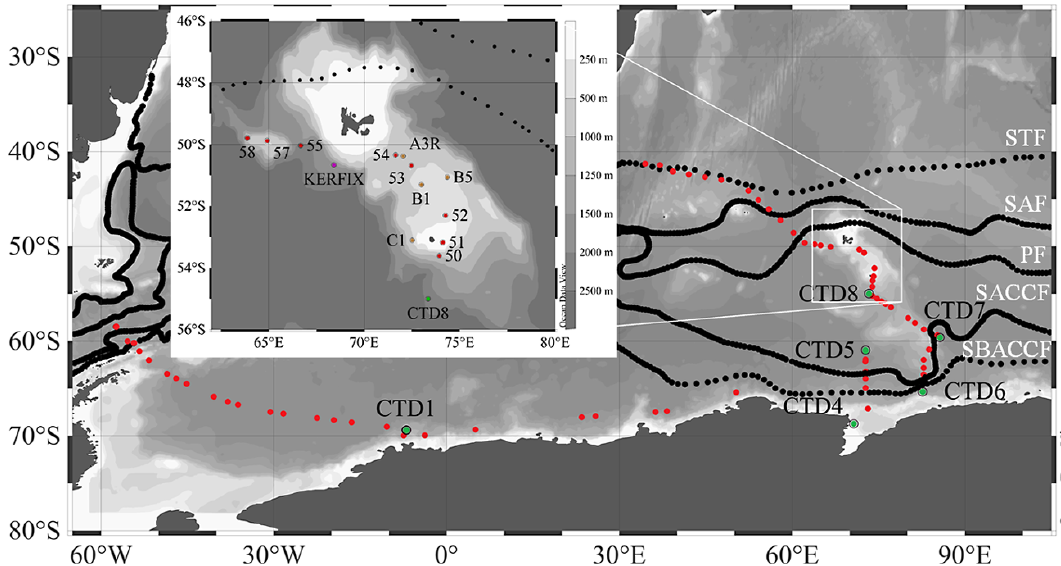
Fig. 1. Map of the study area in the Atlantic and Indian sectors of the Southern Ocean. Red dots are surface water samples from De La Rocha et al. (2011) and green dots represent the CTD stations from this study. The inset shows the area from the north of Kerguelen Island to the south of Heard Island to show the Kerguelen Plateau in more detail. Stations numbered A3R, B1, B5 and C1 are KEOPS stations from Fripiat et al. (2011b), the KERFIX time series site is from Jeandel et al. (1998), stations numbered from 50 to 55 are surface samples from De La Rocha et al. (2011), and CTDs from 1 to 8 are from this study. Black lines represent the Subtropical Front (STF), the Subantarctic Front (SAF), the Polar Front (PF), the Southern Antarctic Circumpolar Current Front (SACCF), and the Southern Boundary of the Antarctic Circumpolar Current Front (SBACCF) of the Antarctic Circumpolar